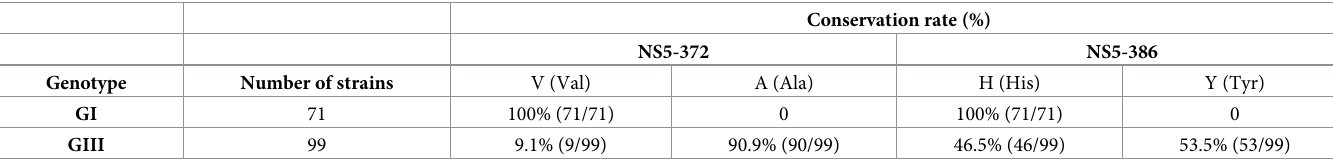
Table 2. Conservation of residues at NS5-372 and NS5-386 in GI and in GIII